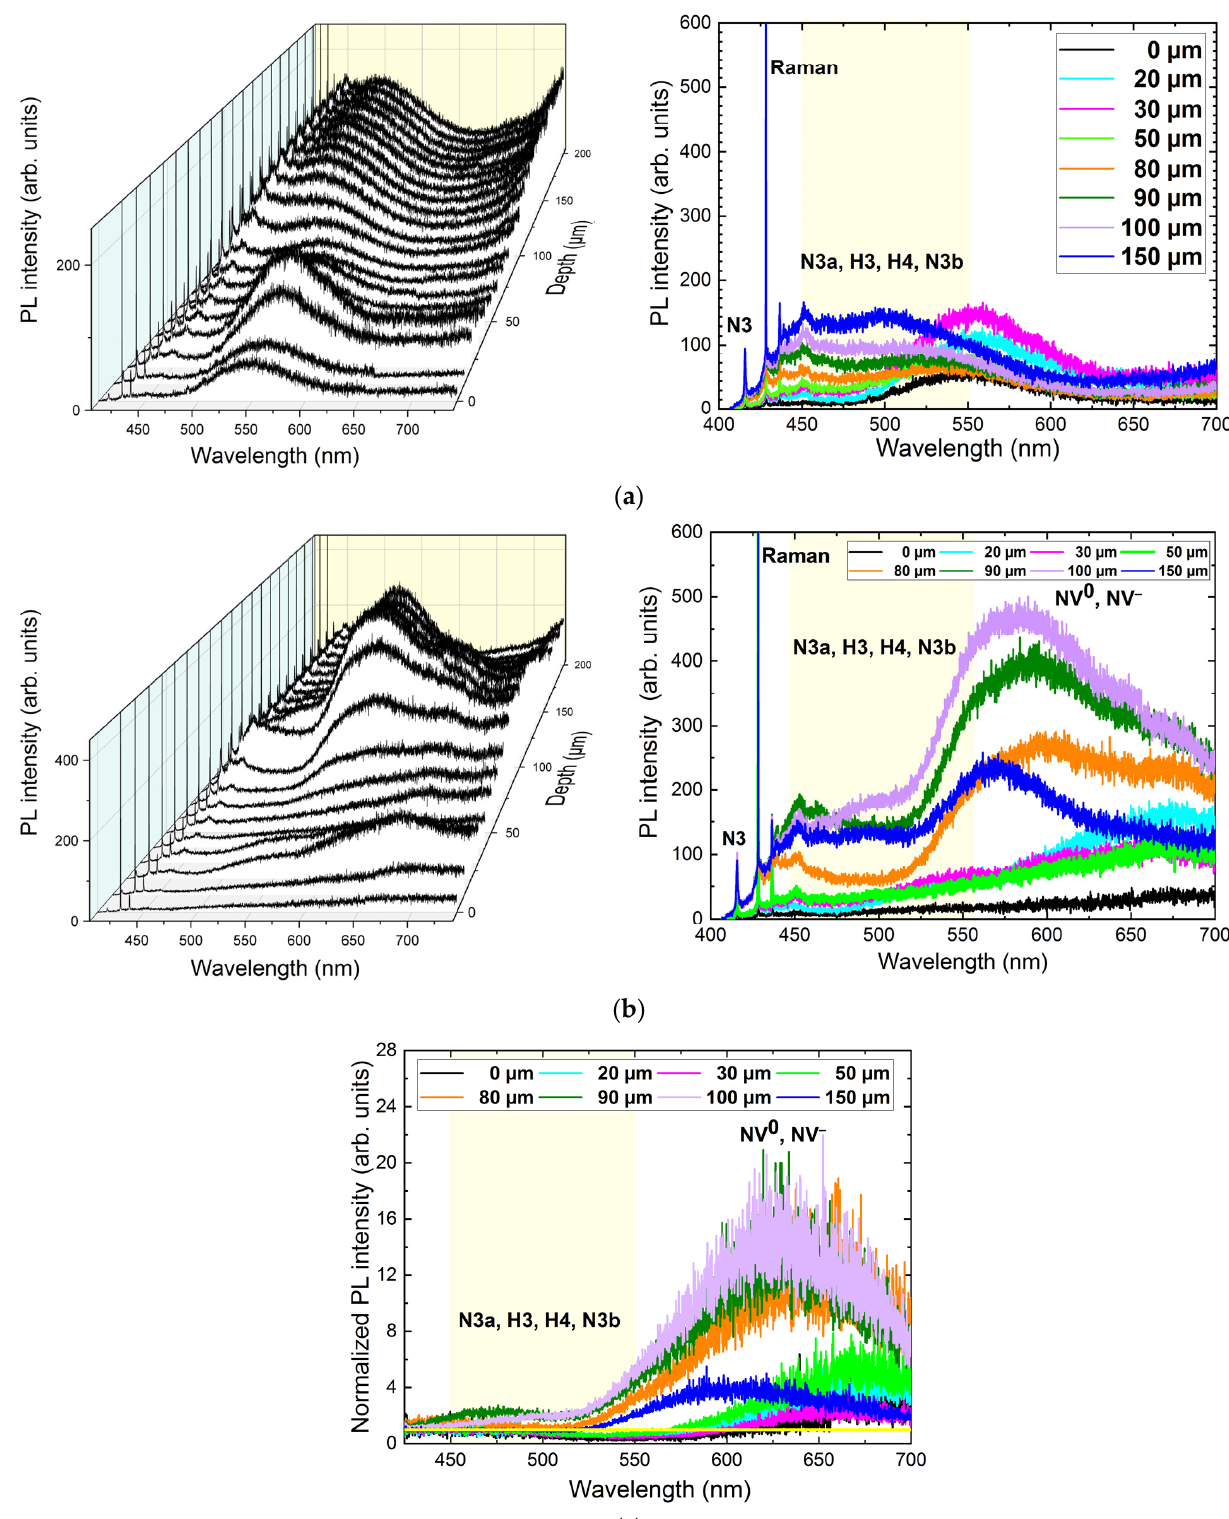
Figure 6. The 405 nm excitation PL spectra of the background ( a ); micromarks ( b ); their normalized intensity ( c ) at different depths inside the sample (irradiation: 240 s exposure time (24M pulses), 0.3 ps, laser pulse energy—1.6 µJ; spectral assignment after).